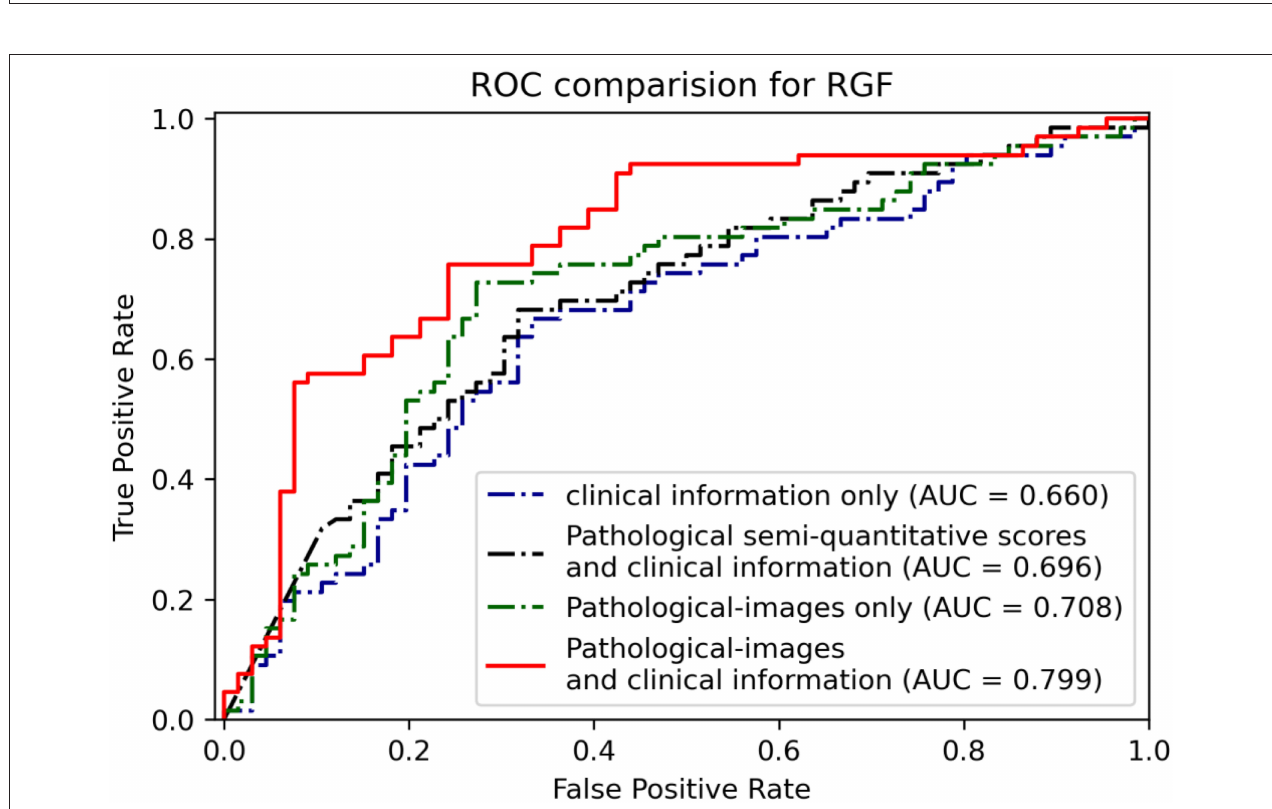
FIGURE 6 | Receiver operating characteristic curves and AUCs show the binary classification results of different models for predicting RGF.